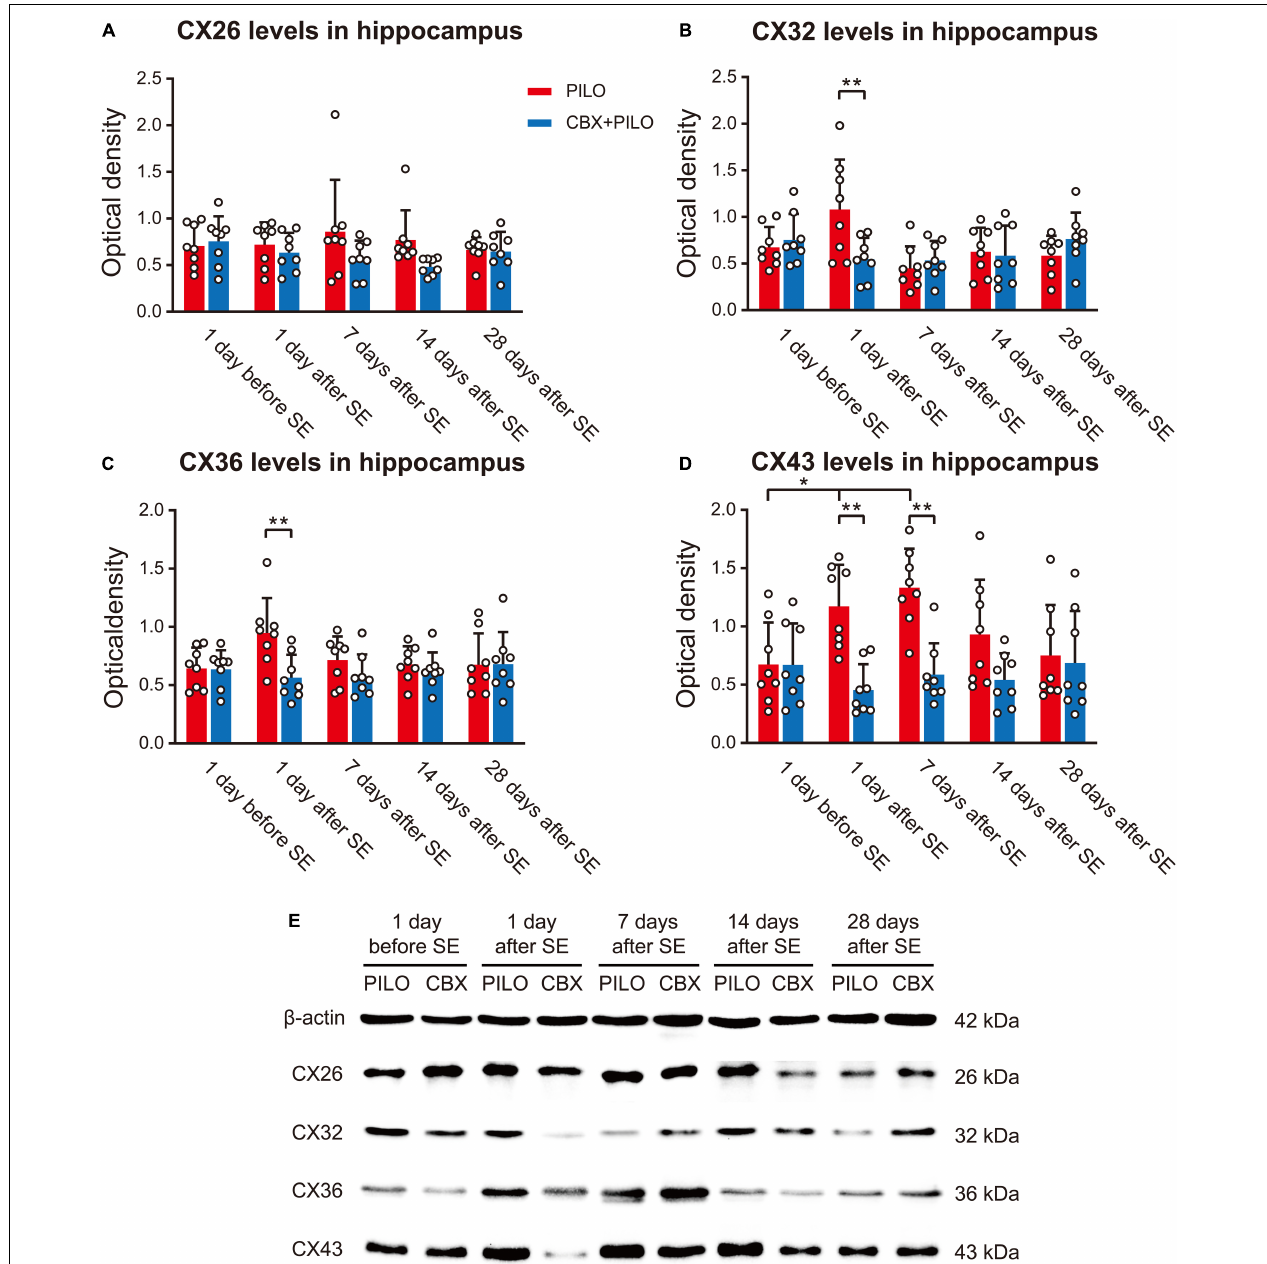
FIGURE 4 | Expression of four kinds of CXs. (A–D) Western blot showing the expression of CX26, CX32, CX36, and CX43 in the hippocampus before and after SE in the PILO and CBX + PILO groups. (E) β -actin is used as a loading control. Each bar represents the mean ± SD of eight separate assays. * P < 0.05, ** P < 0.01; CX,